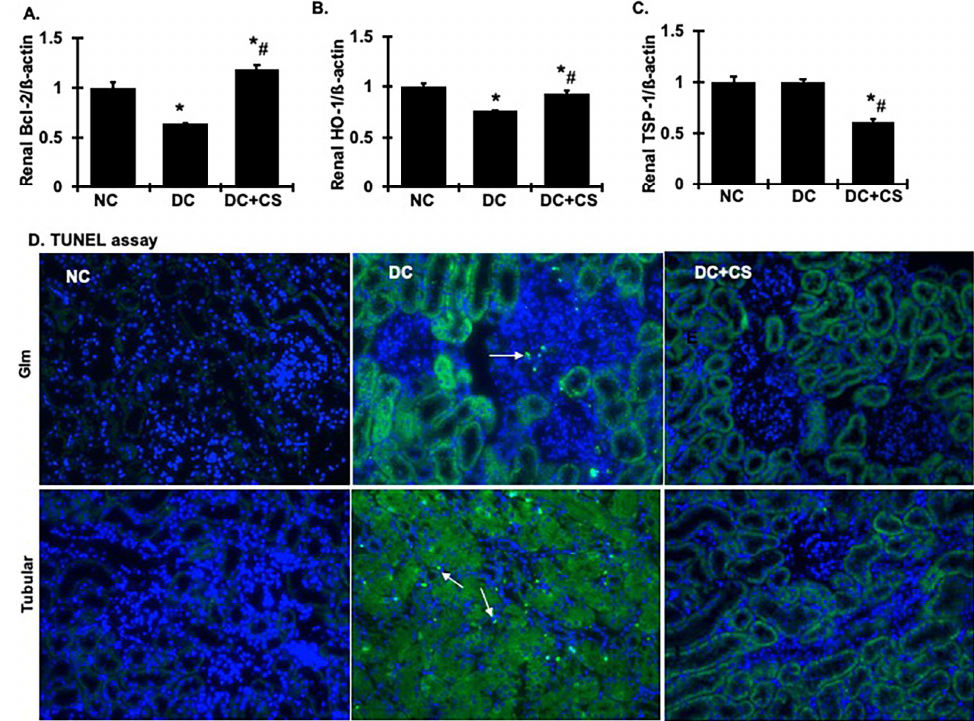
Figure 8. rBMSC sheets ameliorate apoptosis related mRNA expression and TUNEL-positive cells in renal cortex tissue of CGN rats. ( A – C ) Expression of Bcl-2, HO-1, and TSP-1 mRNA in renal cortex tissue. Expression of mRNA was determined by real-time RT/PCR. Changes in mRNA levels were determined by first correcting the amplification of ß-actin for each sample. ( D ) Representative micrographs of TUNEL staining at 200 × magnification for glomeruli (Glm) and tubulointerstitial area (Tubular). DAPI (in blue) stained nuclei served as cell counterstaining. White arrows indicate TUNEL-positive cells. Analysis of renal TUNEL-positive number of cells was included in the text (NC, 0.152 ± 0.152; DC, 28.37 ± 8.57, and DC + CS, 3.453 ± 1.643, per 1000 cells). * vs. normal control rats (NC), p < 0.05; # vs. disease control rats DC, p < 0.05. DC + CS, diseased rats received rBMSC sheets transplantation.